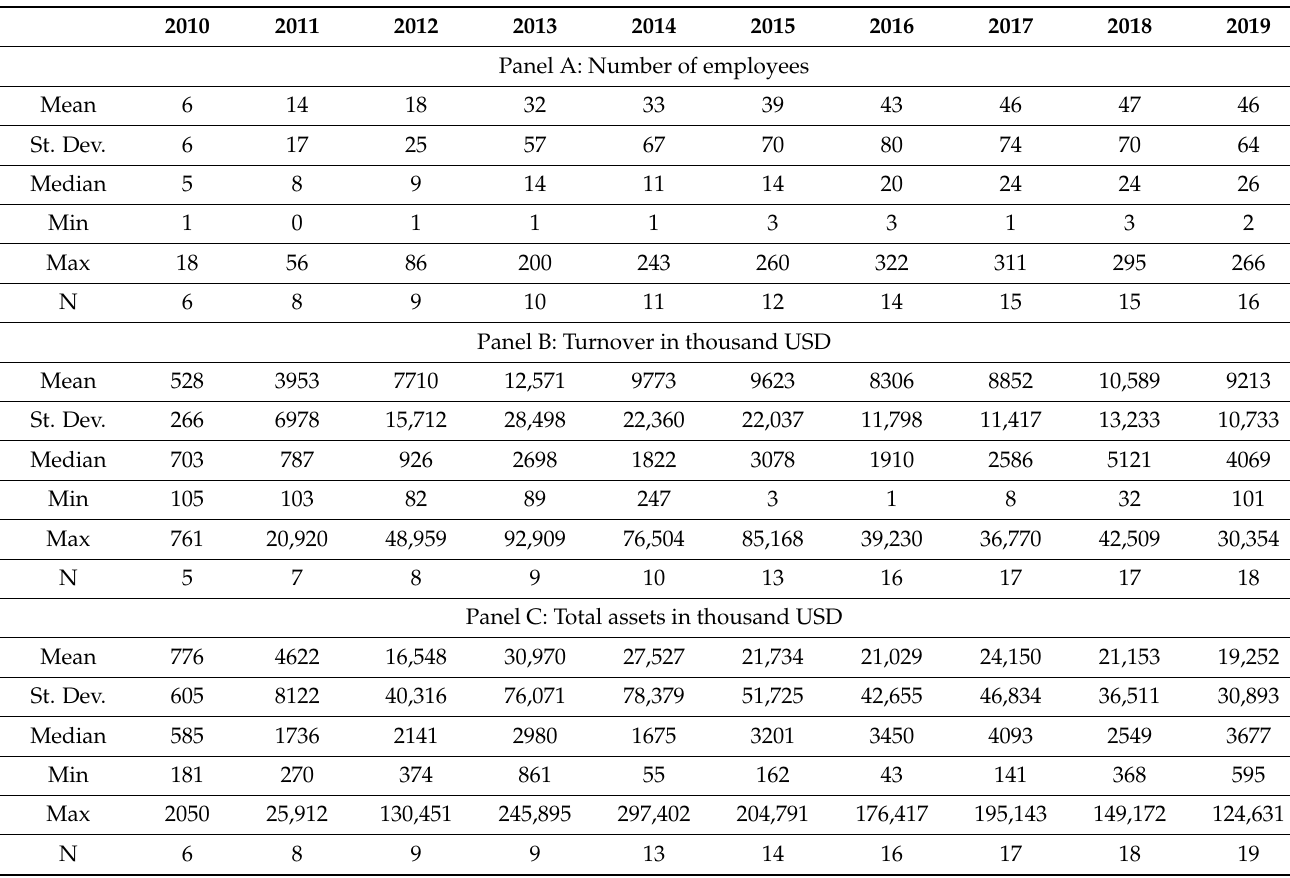
Table 5. Size of FinTech